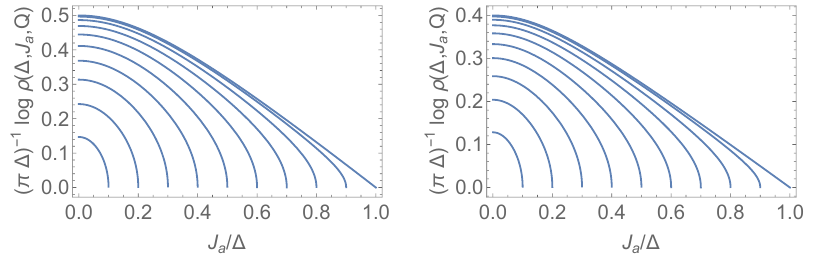
Figure 3. The bound for operators with spin J a and charge Q in d = 3 (left) and d = 4 (right). From right to left, thick curves range from Q= (cid:1) = 0 to Q= (cid:1) = 1 (in d = 3) or Q= (cid:1) = 1 = d = 4) in increments of : 1. In both plots, the dashed line is the horizon entropy per mass of the BPS black hole S BH =(cid:25) (cid:1).